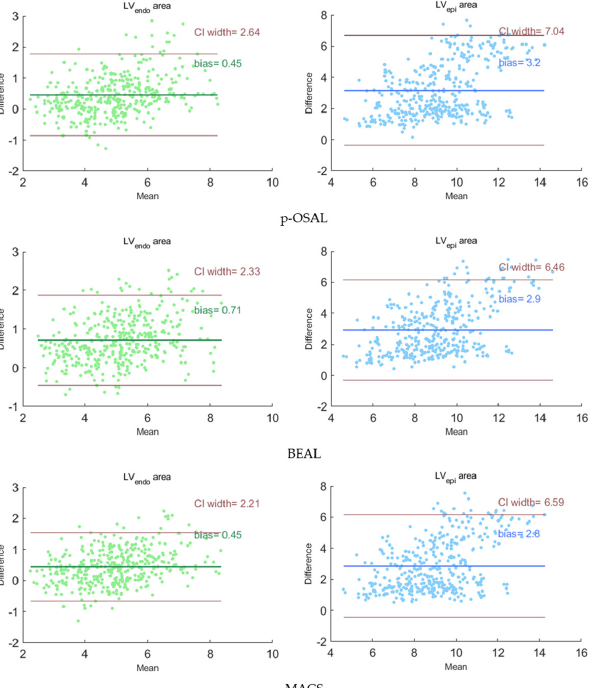
Figure 7. The Bland-Altman analysis on adversarial learning methods about the organ area (×10 3 pixel 2 ). The x-axis represents the average area of the prediction and the ground truth (GT). The y-axis represents the bias of the area of the prediction and the GT. The forest green or royal blue line indicates the bias of the organ area and brown lines indicate 95% confidence intervals of the area bias.